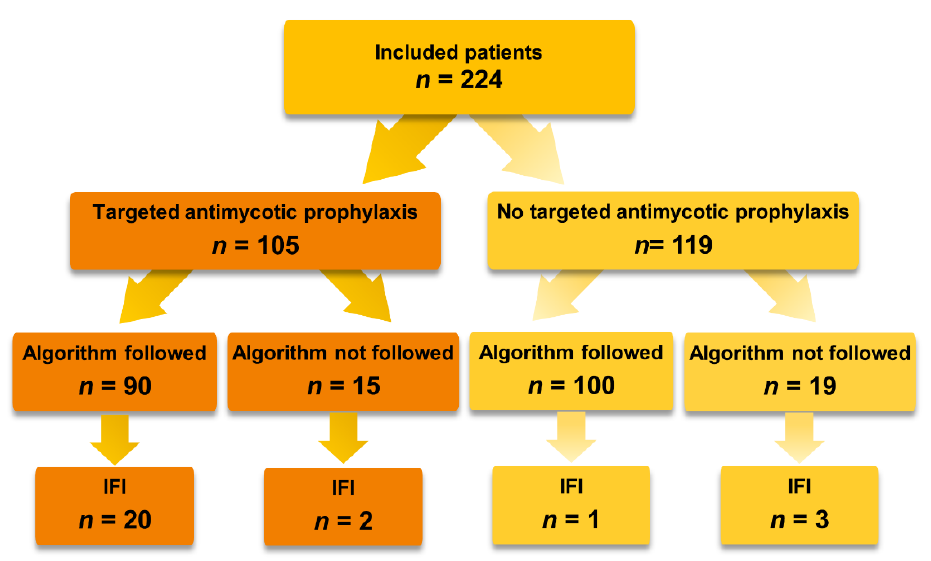
Figure 2. Flowchart of Targeted Antimycotic Prophylaxis (TAP) adherence.